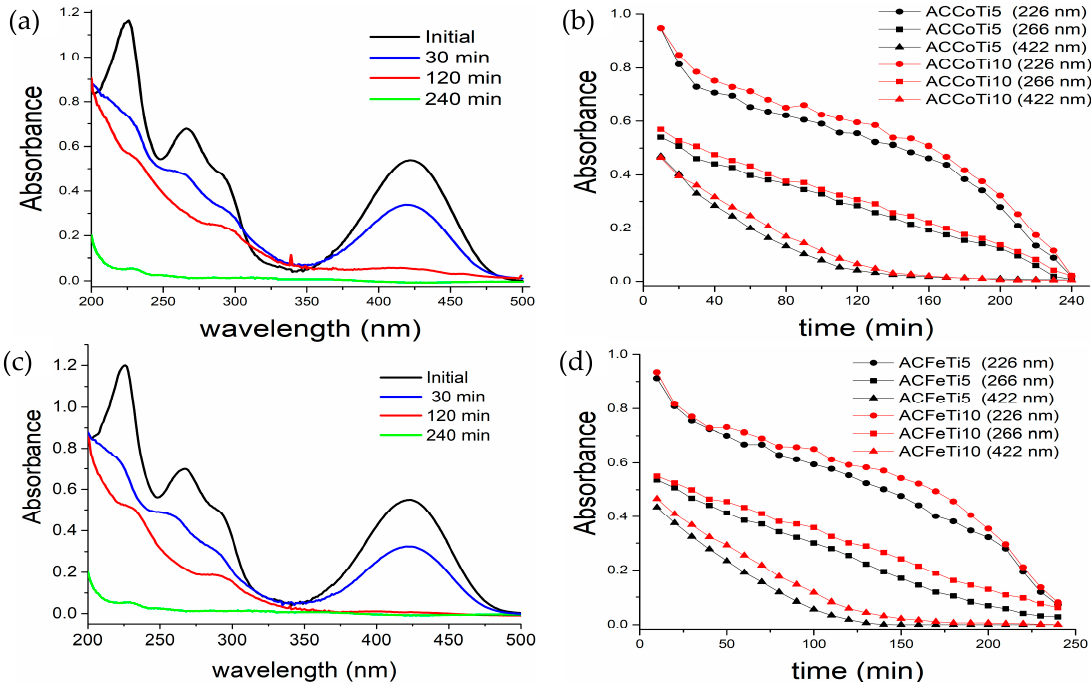
Figure 5. UV–Vis spectral changes of the CYF-4G as function of time under visible irradiation for ( a ) ACCoTi5 ,and ( c ) ACFeTi5. Absorbance changes at 226 nm, 267 nm, and 420 nm for ( b ) ACCoTi5 and ACCoTi10, and ( d ) ACFeTi5 and ACFeTi10.